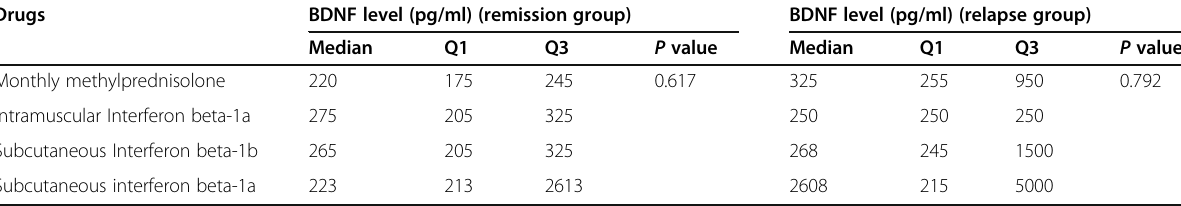
Table 5 Comparison between patients administered different drugs for MS regarding BDNF level Drugs BDNF level (pg/ml) (remission